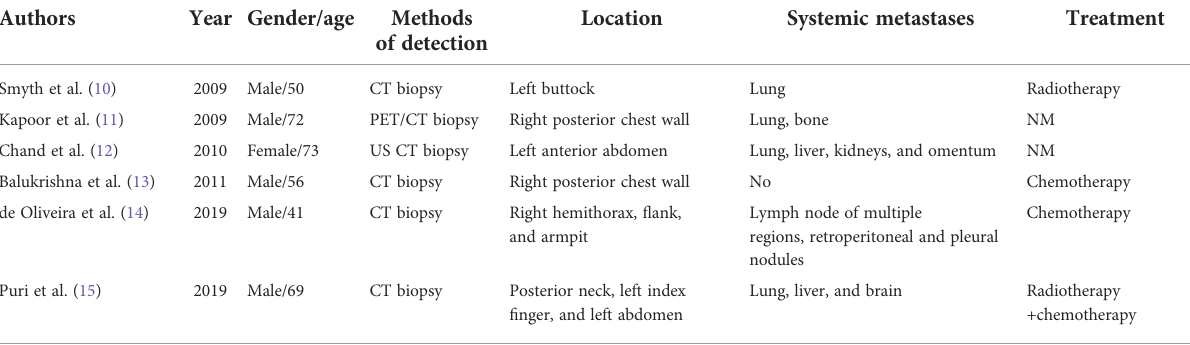
global differences between metastases associated with ESCC versus EA.